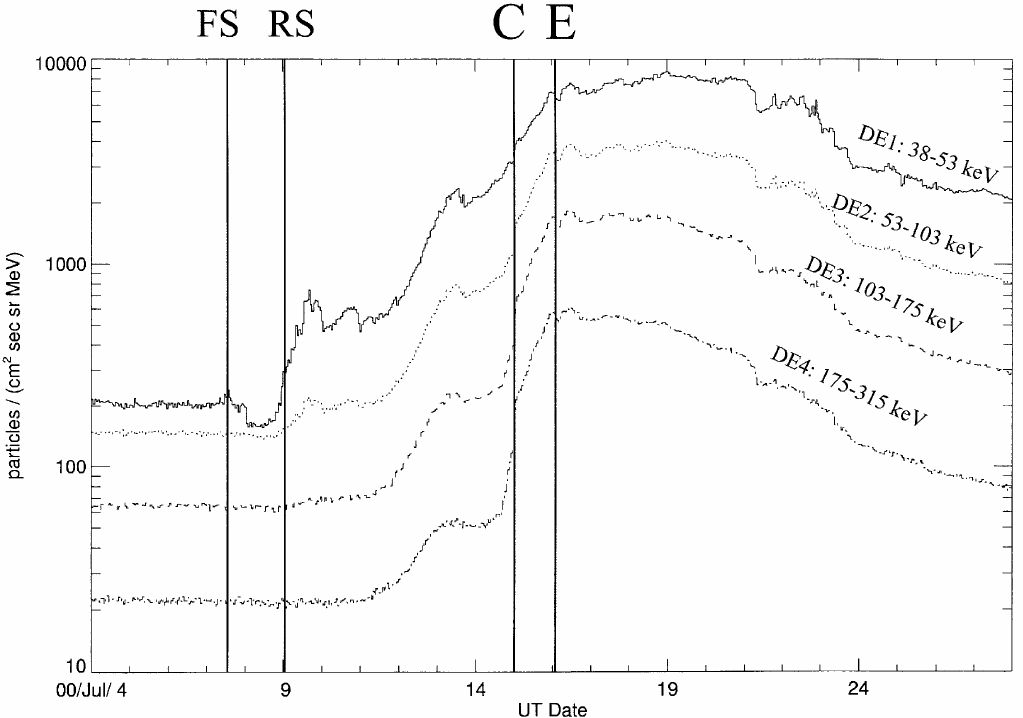
Fig. 4. An ICME was observed by ULYSSES at 62 ◦ south heliolatitude during the major solar electron event associated with the Bastille Day solar